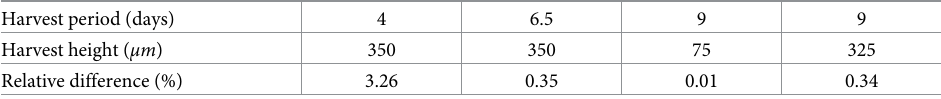
Table 1. Relative productivity difference between 1D and 2D numerical simulations for the whole biofilm (ie. A +N+E) in the case of a uniform